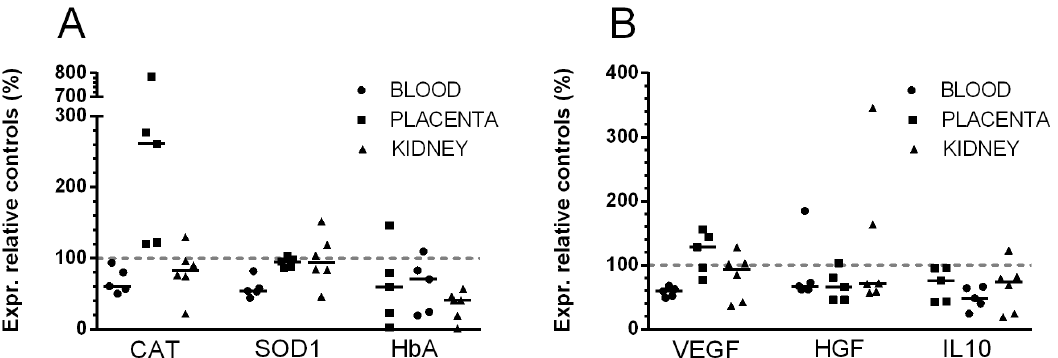
Figure 11. The effect of starvation on gene expression, in blood, placenta and kidney tissues. The target gene expression in pregnant healthy control ewes was analyzed and the median value was set to 100% (represented by a dash-dot line). The relative gene expression in the starved, placebo-treated ewes, are shown as scatter plots with medians. The levels are normalized to b -actin. A. The effect on oxidative stress genes and HbA. There were a significant decrease of CAT and SOD1 mRNA expression in white blood cells (p-values , 0.043 and , 0.008 respectively). The CAT mRNA expression was up-regulated 2.6-fold in the placenta and the HbA mRNA expression was down-regulated 3.3-fold in the kidneys. B. The effect on genes related to angiogenesis and inflammation. There was a significant decreases of VEGF, HGF and IL10 in white blood cells (p-values , 0.02, , 0.06 and , 0.08, respectively). HGF and IL10 mRNAs expression showed down-regulation to comparable extent in the placenta, but not VEGF. In the kidneys, none of the genes were significantly affected by starvation.